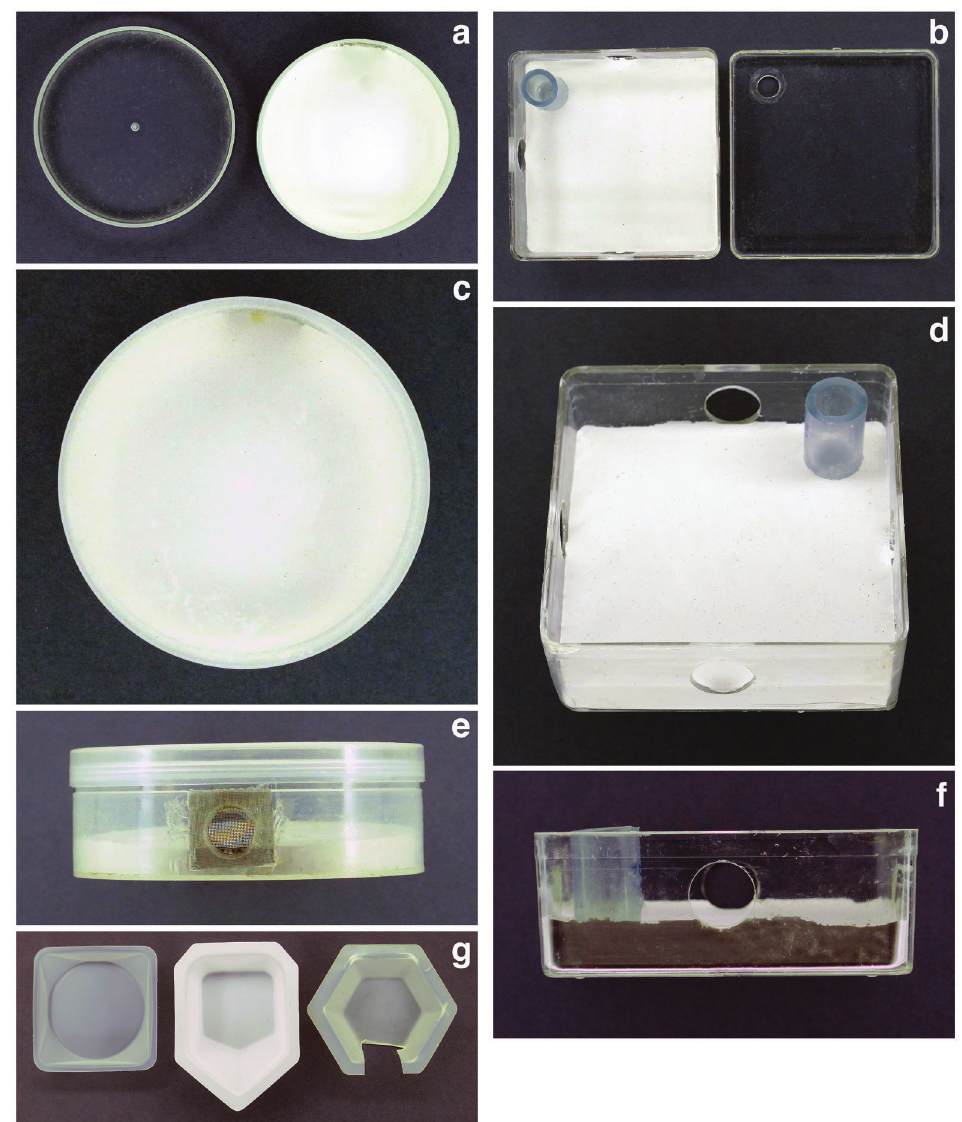
Fig 5. Nest boxes used in the NMNH Ant Lab. a. Round, flexible, snap-top polypropylene nest box with plaster, seen from above, with lid. b. Small, square, polystyrene nest box with plaster, seen from above, with lid. Water well and tube in upper left corner. c. Round polypropylene nest box with lid affixed, seen from above. d. Square nest box, oblique view. Water well in upper right corner. e. Round nest box, lateral view, with ~0.7 cm diameter hole covered with fine-mesh, stainless-steel wire screen for air exchange. f. Square nest box, lateral view, with ~1 cm diameter hole for connections with other boxes. g. Various weigh boats used for serving food in auxiliary foraging boxes and also used as platforms to separate fungus gardens from the plaster nest box